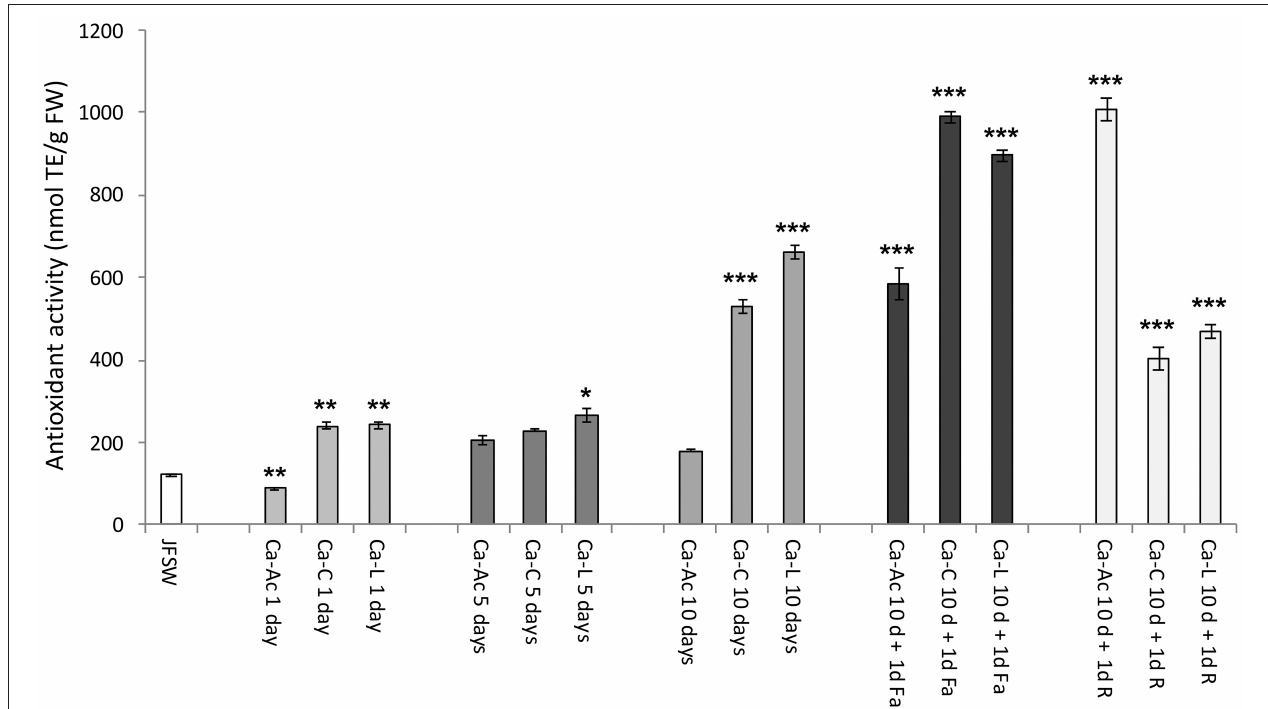
FIGURE 3 | Antioxidant activity in JF samples. Antioxidant activity in control (JFSW) and in the different treatments used: Ca-Ac (calcium acetate), Ca-C (calcium-citrate), Ca-L (calcium lactate) for 1, 5, and 10 days; Ca-Ac 10 d + 1d Fa (ferulic acid added to JF already treated for 10 days with Ca-Ac), Ca-C 10 d + 1 d Fa (ferulic acid added to JF already treated for 10 days with Ca-C), Ca-L 10 d + 1d Fa (ferulic acid added to JF already treated for 10 days with Ca-L), Ca-Ac 10 d + 1 d R (rutin added to JF already treated for 10 days with Ca-Ac), Ca-C 10 d + 1 d R (rutin added to JF already treated for 10 days with Ca-C), Ca-L 10 d + 1 d R (rutin added to JF already treated for 10 days with Ca-L). Mean values of three independent measurements. Antioxidant activity is expressed as nmol of TE per g fresh weight (nmol TE/g FW) ± standard deviation. ANOVA statistic test, followed by Tukey’s multiple comparison post-test, was performed to compare each treatment in each incubation condition (1, 5, and 10 days, and 10 d + 1d Fa and 10 d + 1d R) with the control JFSW and between each of them (* p < 0.05, ** p < 0.01, and *** p <